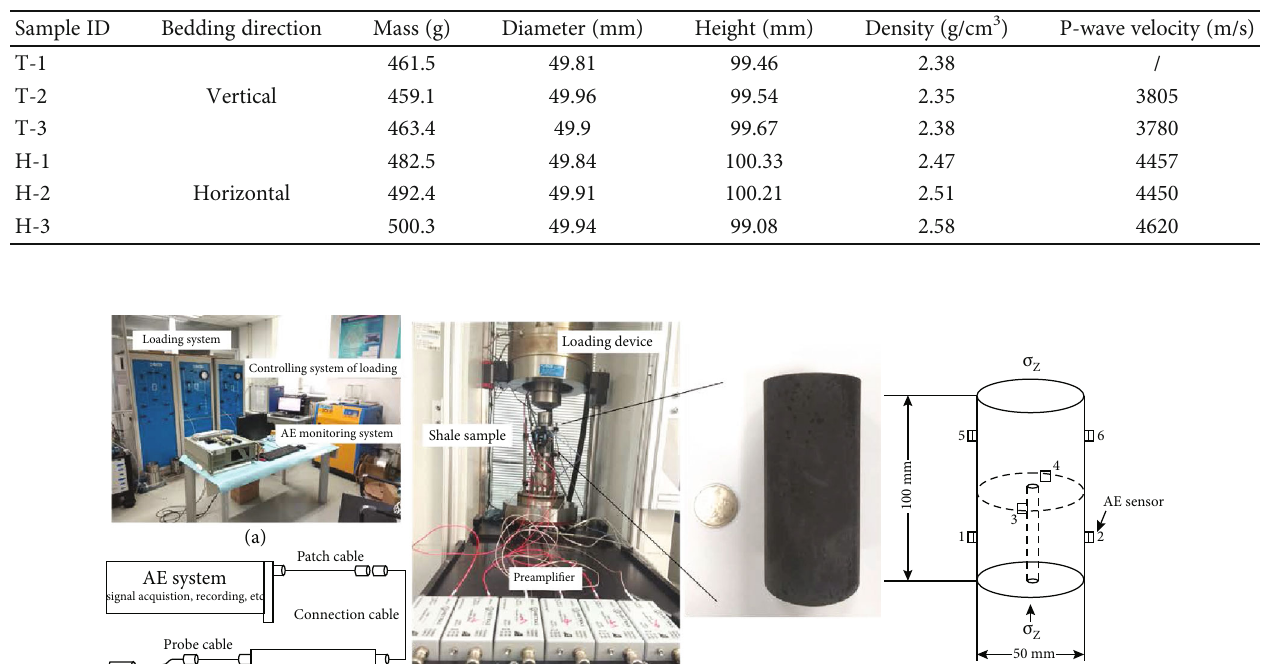
Table 1: Physical properties of the six shale samples.